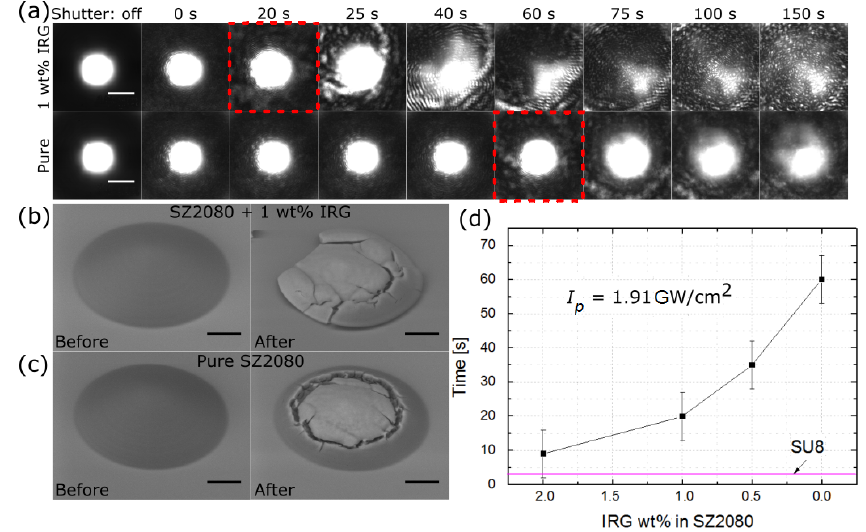
Figure 7. ( a ) real-time monitoring of a lateral intensity distribution of LED through microlenses produced using photosensitized and pure SZ2080 during irradiation with 515 nm 300 fs pulses at 200 kHz with I p = 1.91 GW/cm 2 (spot radius of 100 µ m). Faster deterioration of SZ2080